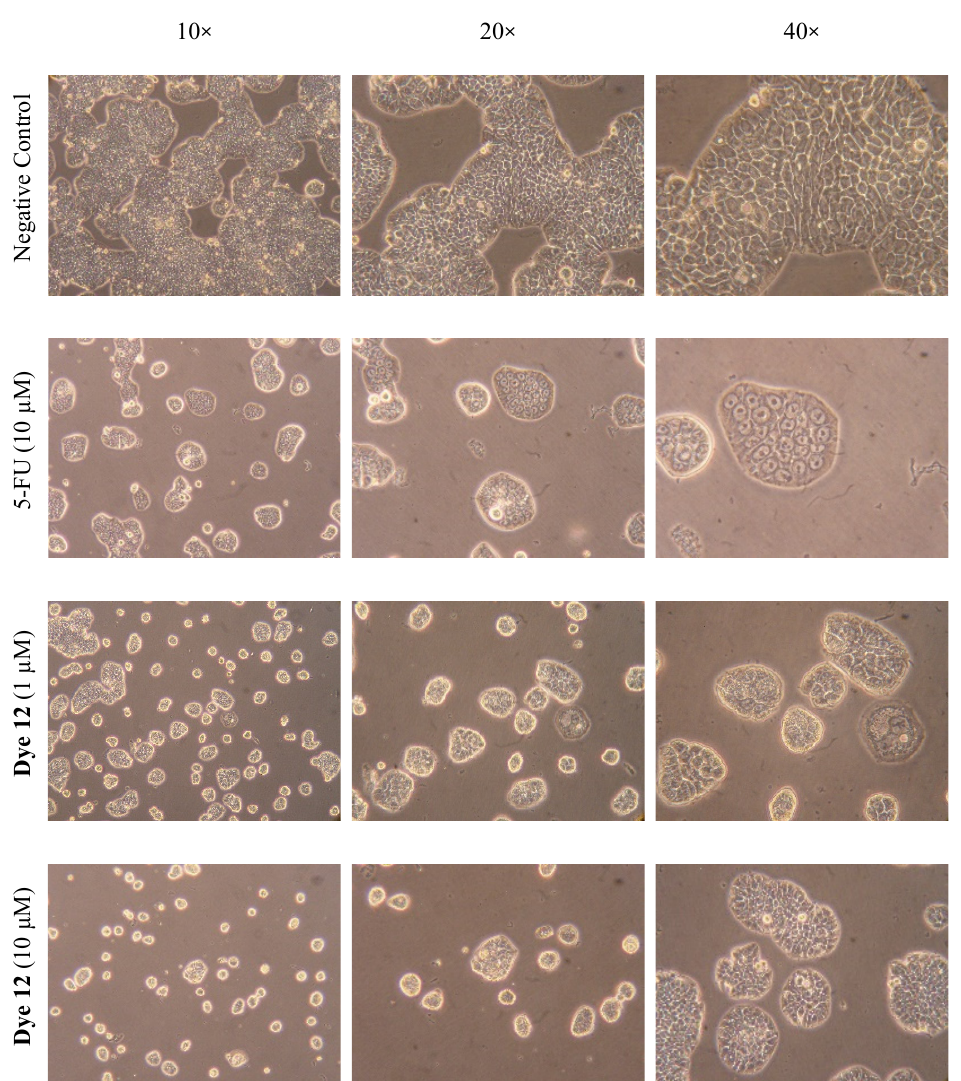
Figure 6. Microscopic images of Caco-2 cells treated in the dark with the monomethine cyanine dye 12 at the concentrations of 1 and 10 µM and 5-FU at the concentration of 10 µM. Images were recorded at 10, 20, and 40× magnification after 72 h of incubation with the tested